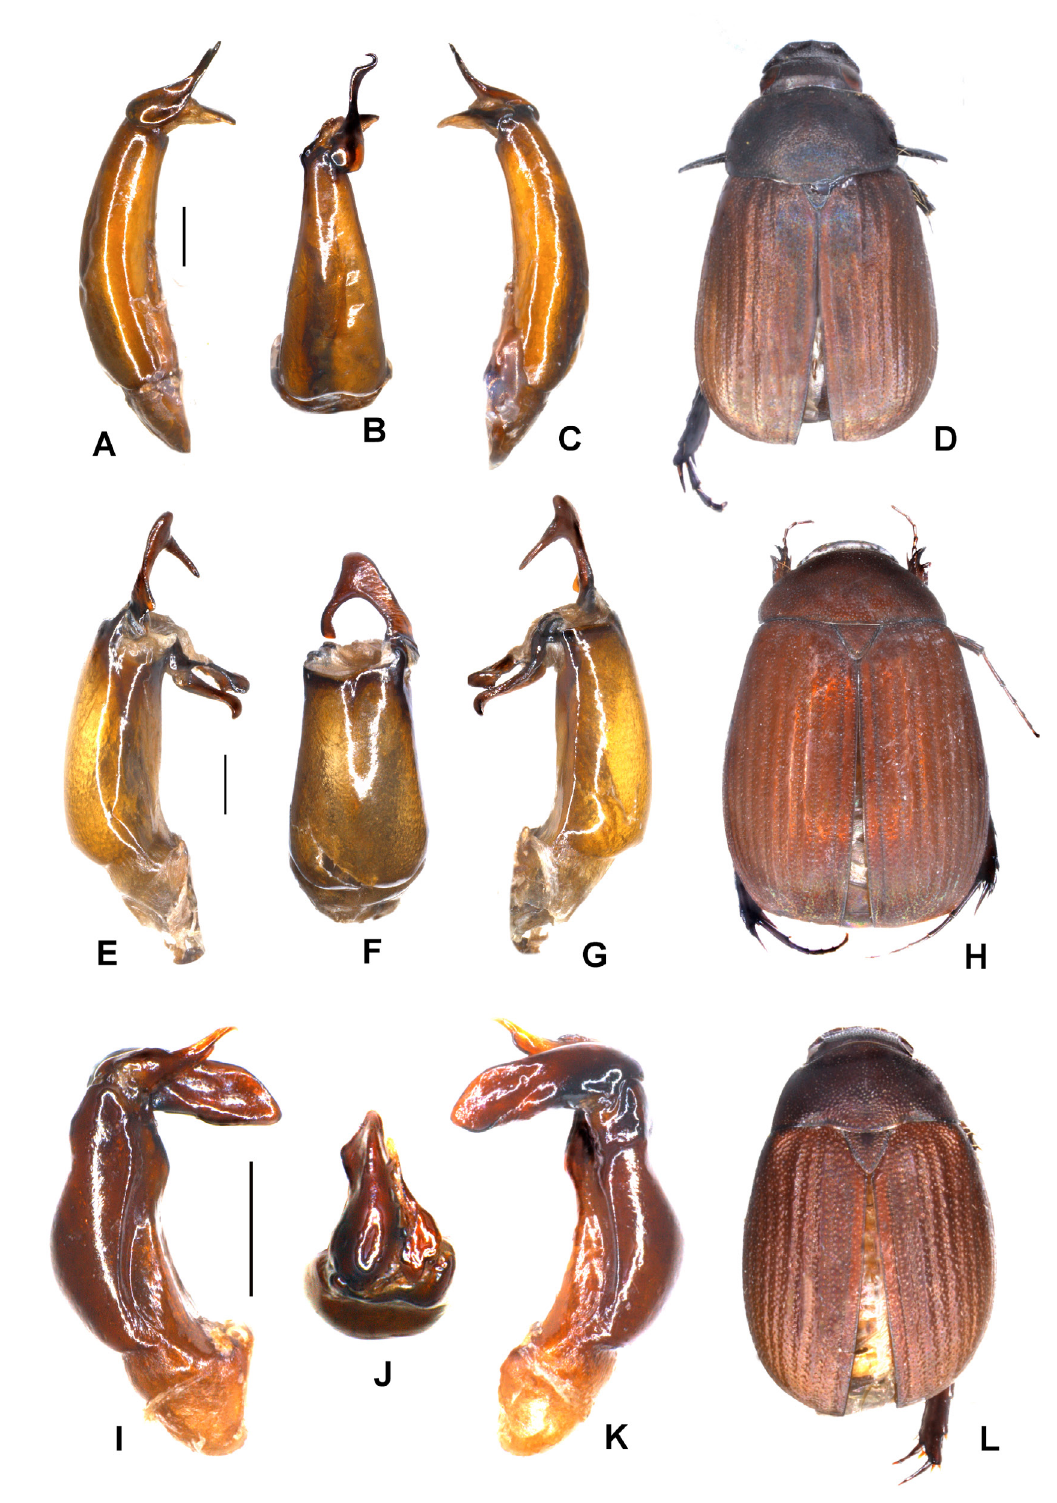
Fig. 2. A–D . Maladera naveeni sp. nov., holotype, ♂. E–H . Maladera sujitrae sp. nov., holotype, ♂. I–L . Maladera thirthahalliensis sp. nov., holotype, ♂. A, E, I . Aedeagus, left side lateral view. C, G, L . Aedeagus, right side lateral view. B, F, J . Parameres, dorsal view. D, H, L . habitus. Scale bars: 0.5 mm. habitus not to